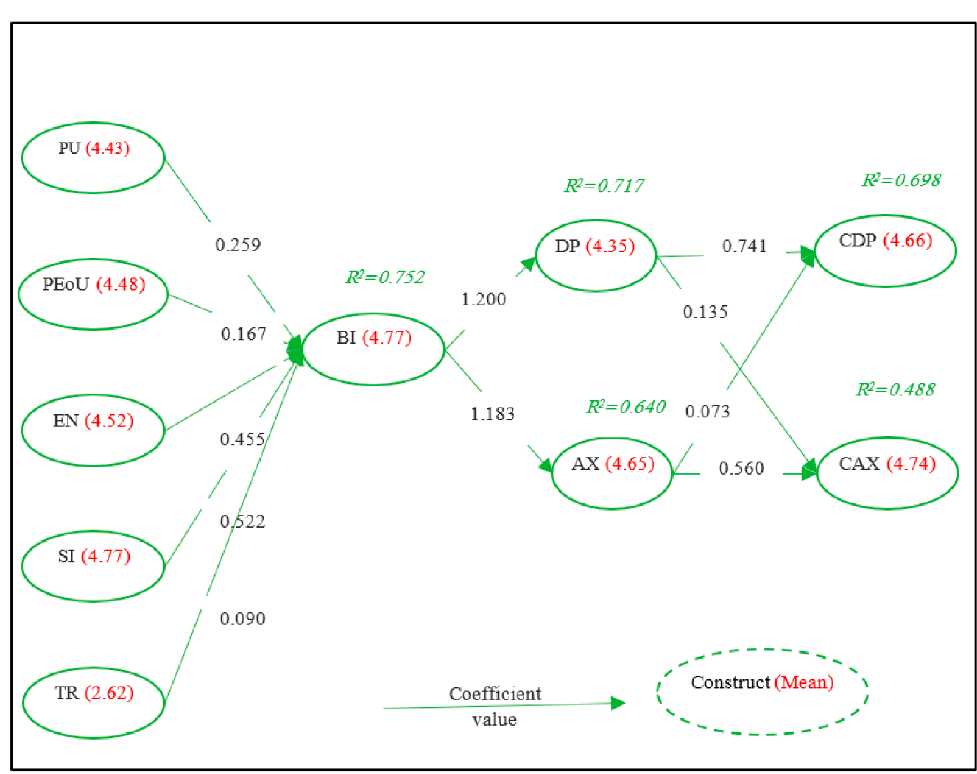
Figure 4. Prosed model of the research with mean, coefficient value, and R-squared.